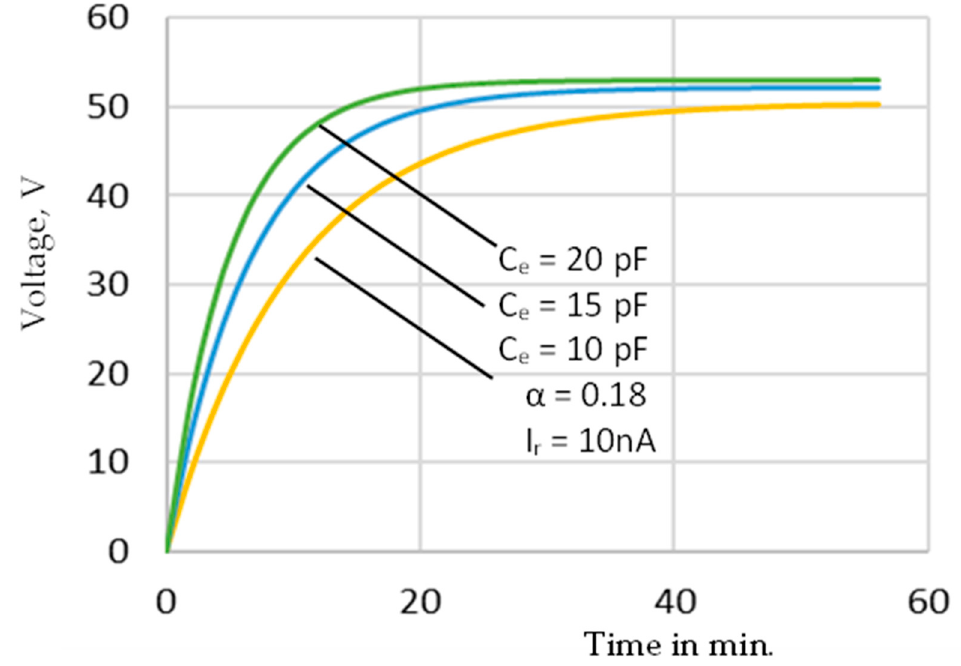
Figure 4. Voltage buildup in Capacitor C 0 with time.